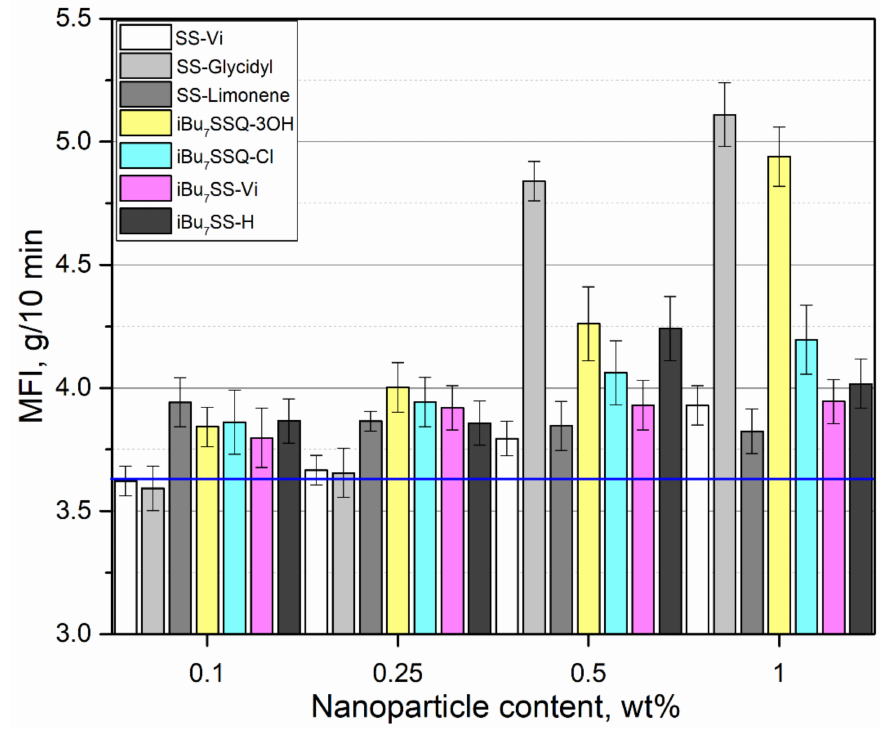
Figure 10. Melt flow index of CS/iPP